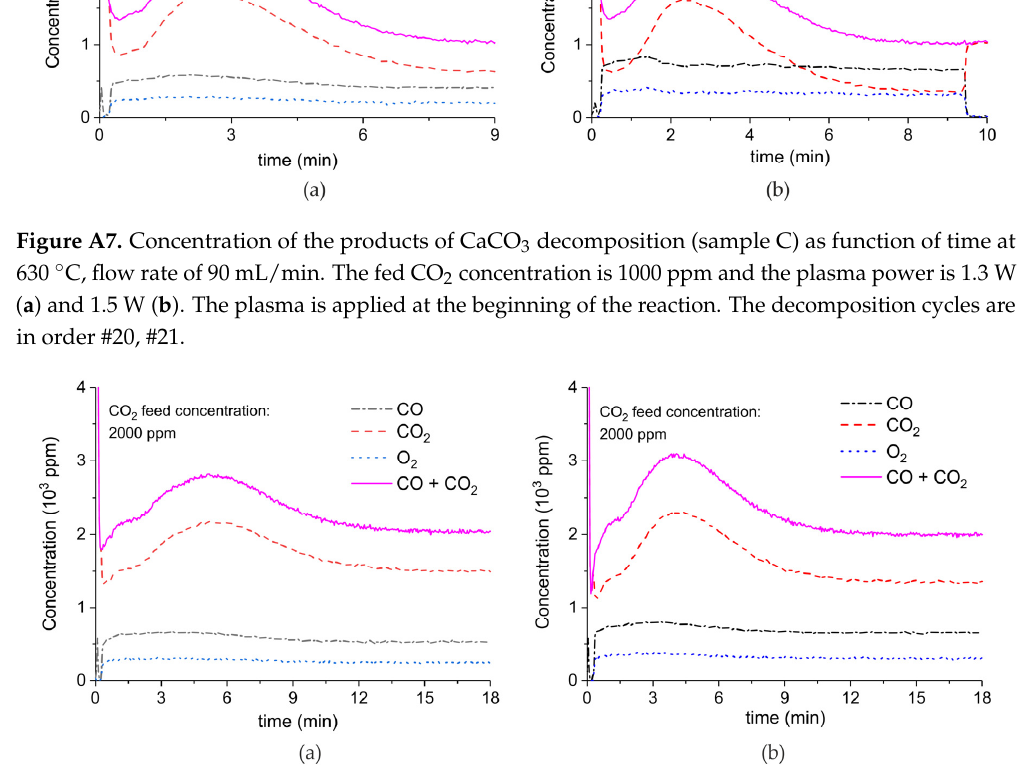
Figure A8. Concentration of the products of CaCO 3 decomposition (sample C) as function of time at 630 ◦ C, flow rate of 90 mL/min. The fed CO 2 concentration is 2000 ppm and the plasma power is 1.4 W ( a ) and 1.9 W ( b ). The plasma is applied at the beginning of the reaction. The decomposition cycles are in order #13,